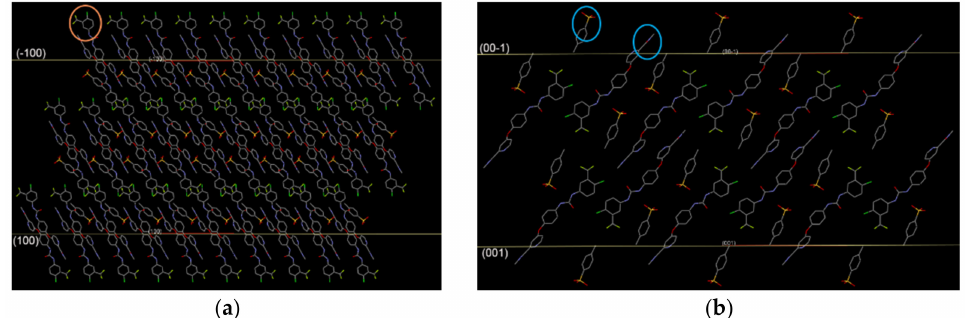
Figure 6. Molecular surface packing visualized along with the surface chemistry of ( a ) the (100) and (-100) as well as ( b ) (001) and (00-1) facets.